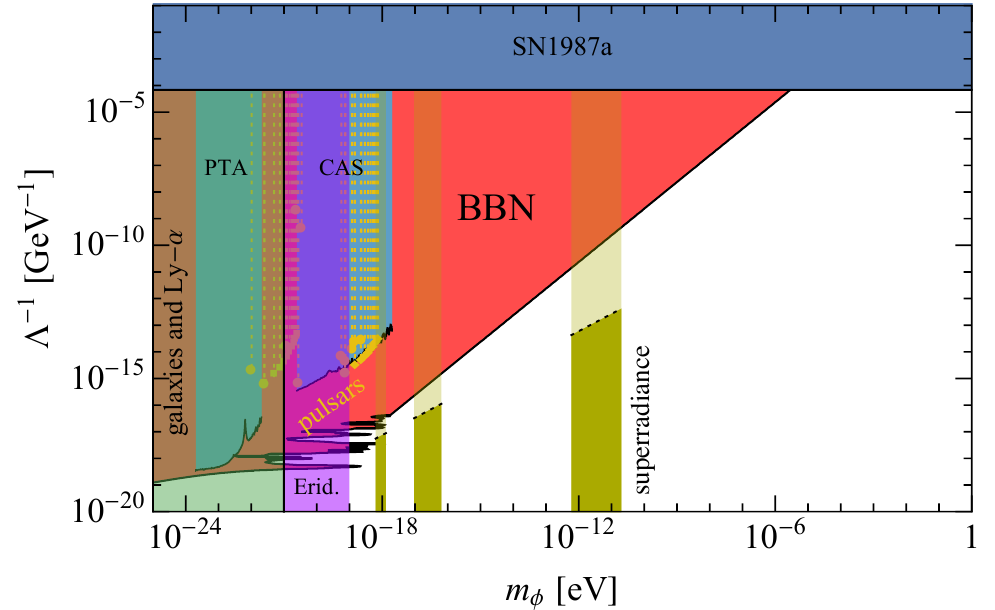
Figure 5 : Summary of constraints on the scale of the universal quadratic coupling, 1 / Λ , as a function of scalar mass m . Only the case of positive coupling is shown. The bounds φ from the 4 He and D abundances are shown in the red shaded region. Additional constraints come from supernova cooling and fifth-force searches (blue), superradiance (yellow), the deBroglie wavelength of the smallest dwarf galaxies along with bounds from Ly- α measure- ments (green), and Eridanus II (purple). Above the black dotted lines, the induced mass from the black hole accretion disk exceeds m and the dynamics of superradiance may φ be affected. The constraints from measurements of the binary pulsar orbital period are given in the yellow dots, corresponding to the resonant bands. Also shown are constraints inferred from the bounds on stochastic gravitational waves by Cassini (CAS) and Pulsar Timing Arrays (PTA). See text for more